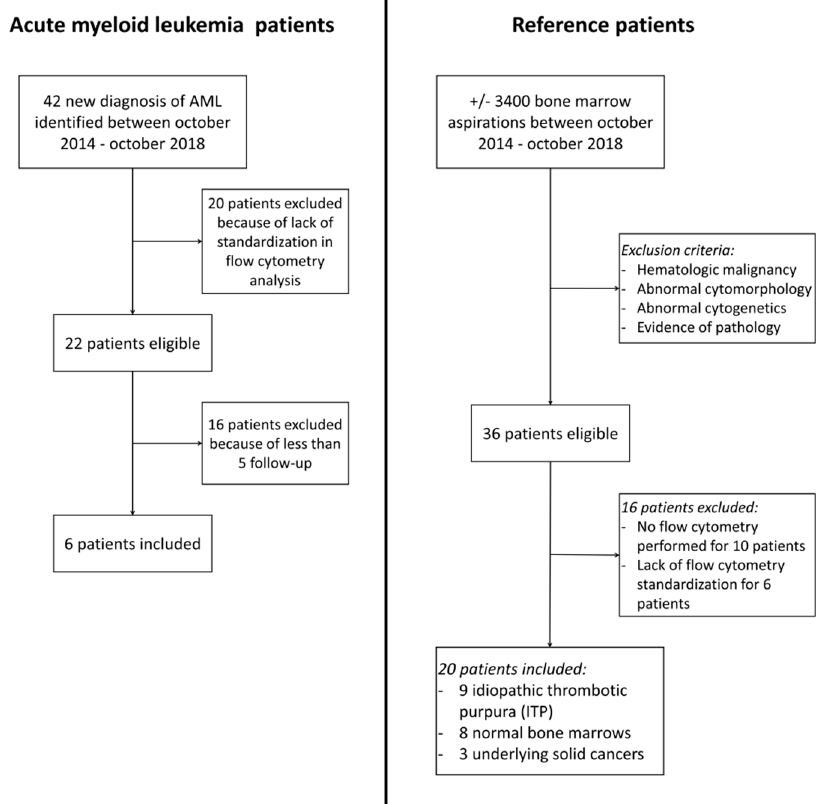
Figure 1. Flow diagram of acute myeloid leukemia patients and reference patients.